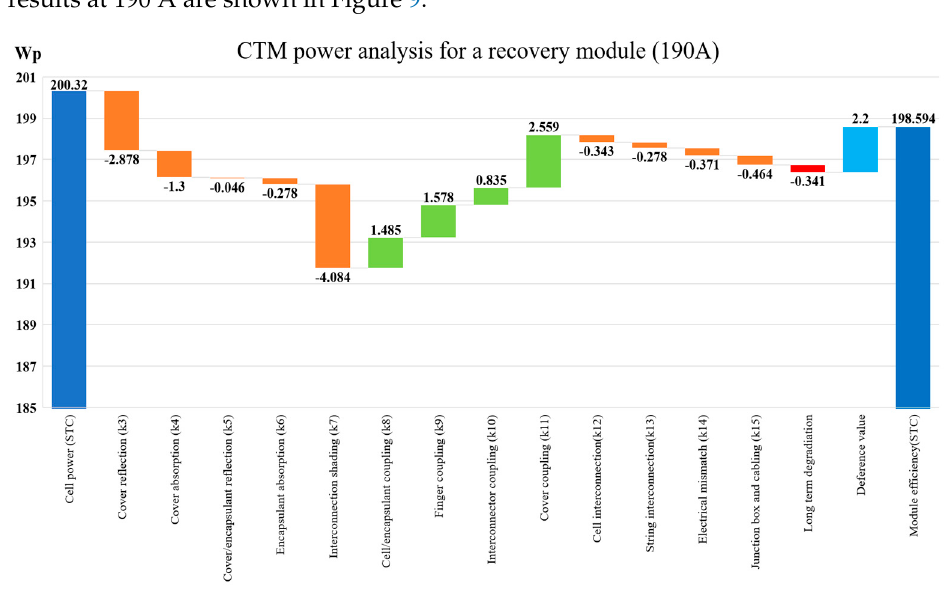
Figure 10. CTM power analysis for a recovered module (190 B). Sample 190 B was of the same grade as 190 A, and because there were fewer replace- ment cells (six), the power acquisition from the replacement cell was smaller than that at 190 A; therefore, the total power output of the cell was calculated as 197.52 Wp. In addi- tion, the numbers of remaining cells in 190 A and 190 B were 44 and 48 cells, respectively; thus, the long-term degradation was then calculated to be − 0.47 Wp, which is greater than